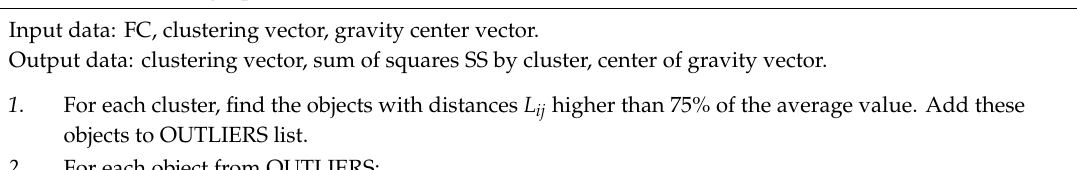
Algorithm 2. Finding a personalized treatment (PTA).